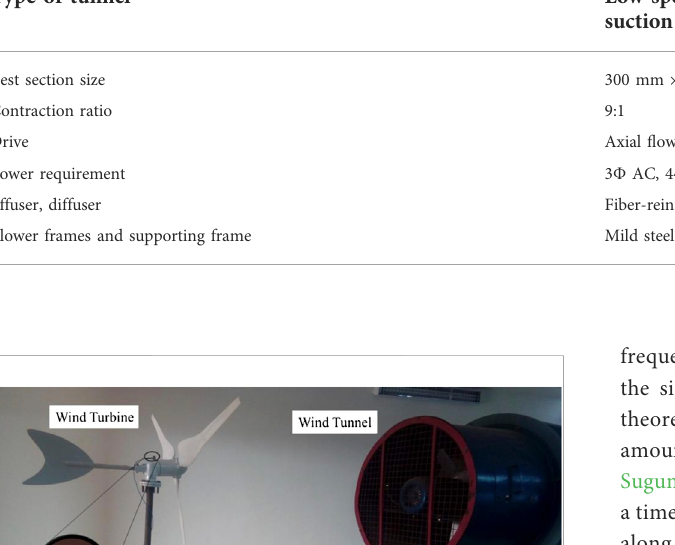
TABLE 3 Technical parameters of the wind tunnel